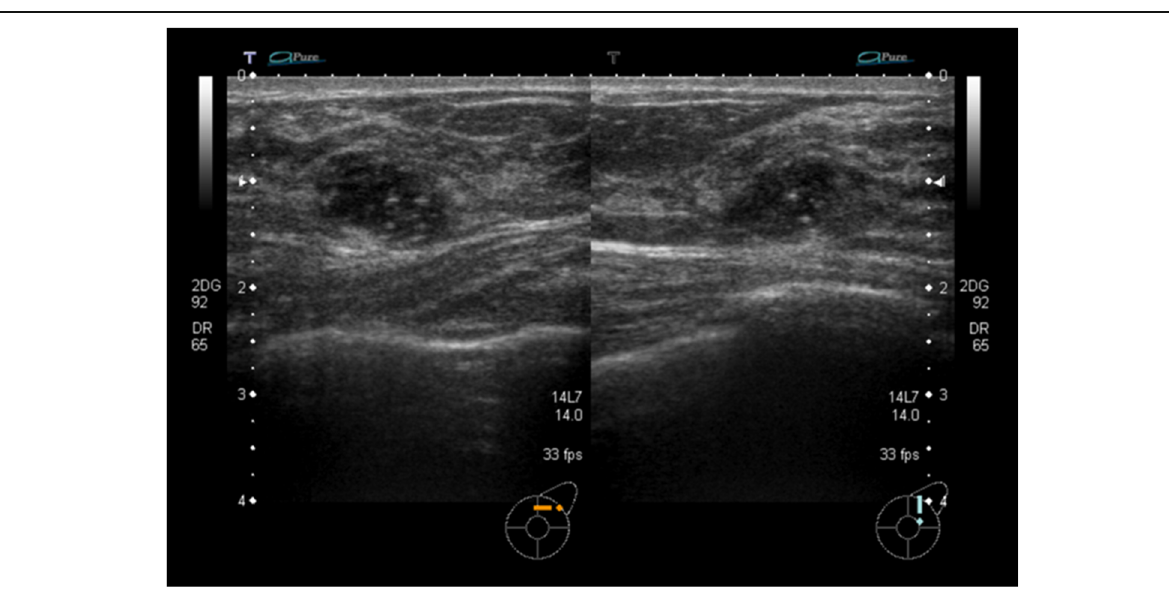
Fig. 2 Ultrasonography. Ultrasonography showing a hypoechoic irregular mass (13 mm × 12 mm × 7 mm) with clear roughening of the boundary and a high echo spot inside in the left CD